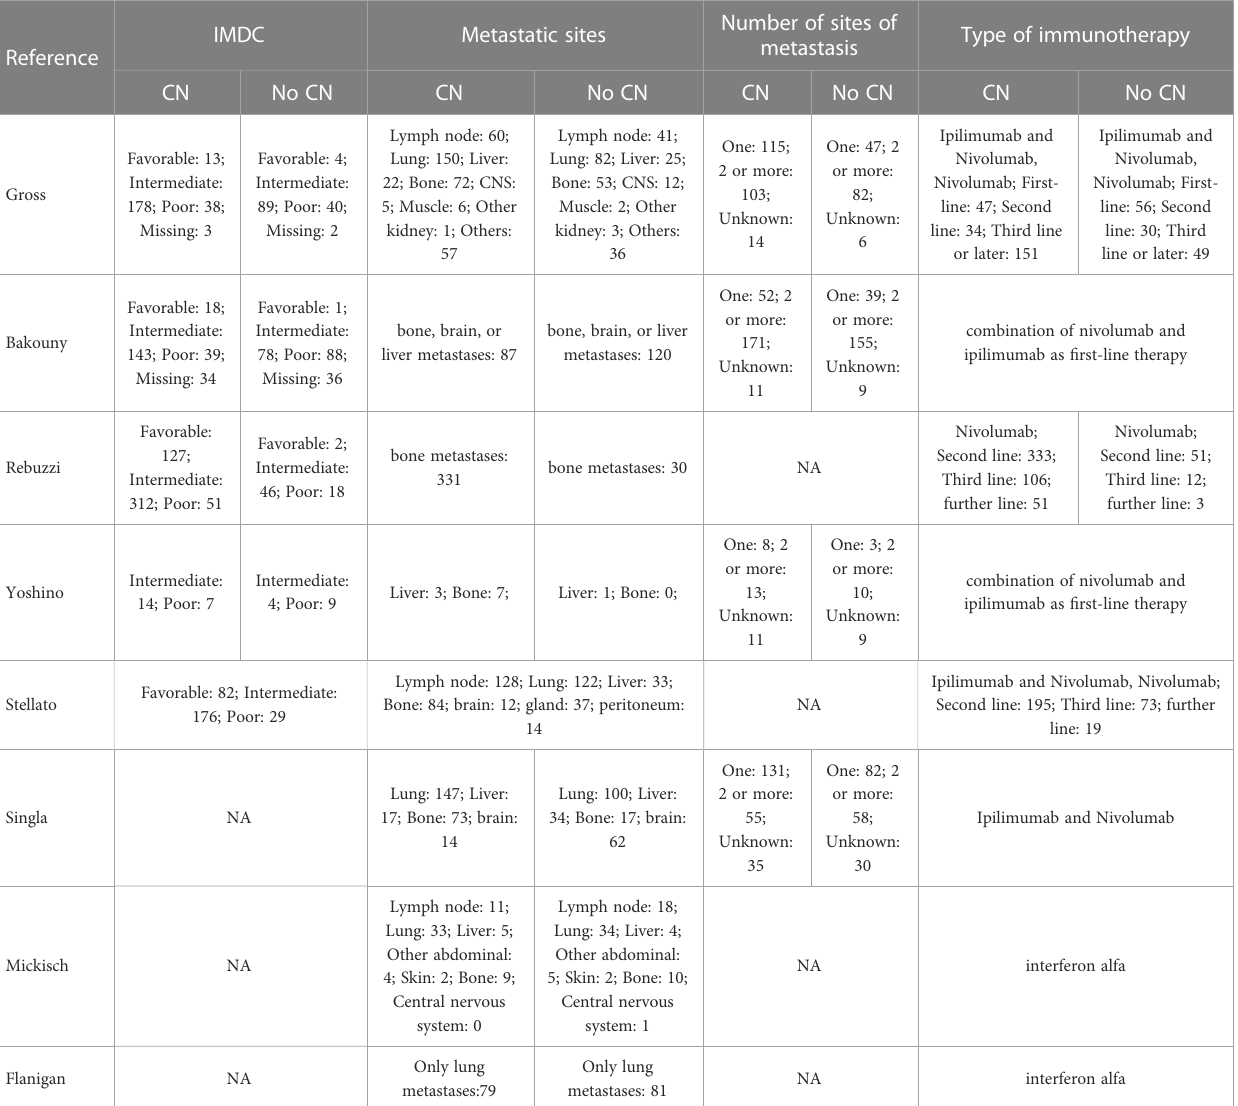
TABLE 2 The trials included in the systemic